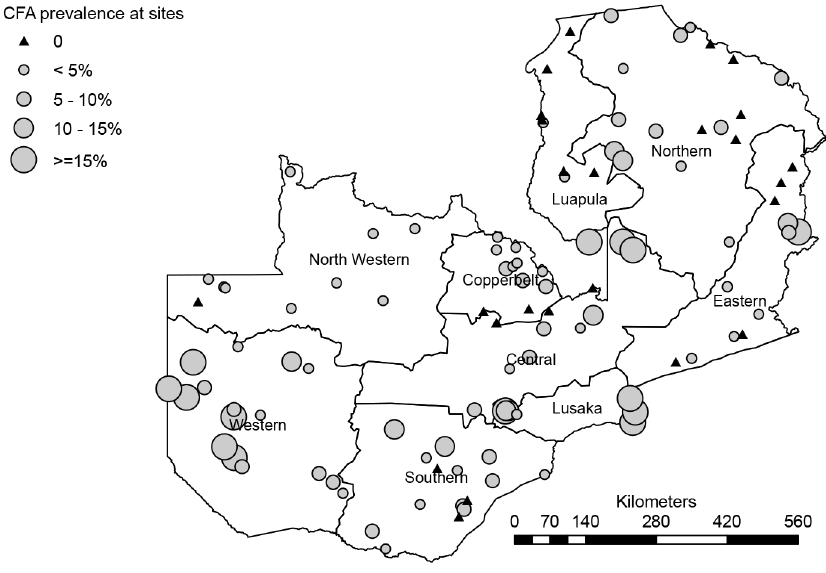
Figure 1. Map of Zambia showing survey sites and prevalences of CFA positivity.